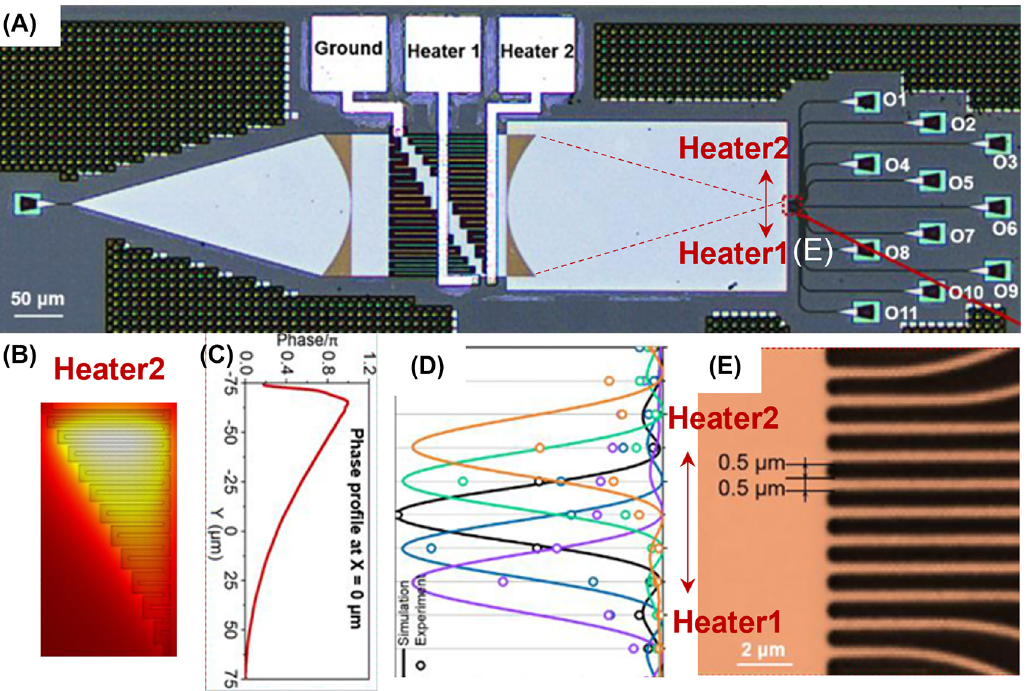
Figure 5: 1 × N switch via on-chip tunable metasurface [85]. (A) The fabricated 1 × 11 switch by Advanced Micro Foundry (AMF). (B) Simulated temperature distribution by powering heater 2, and correspondent (B) wavefront of the transmitted wave incident on the second metalens. (C) The simulated and measured optical intensity profile of each output port on the focal plane. (D) Zoom-in optical image of the output ports on the focal